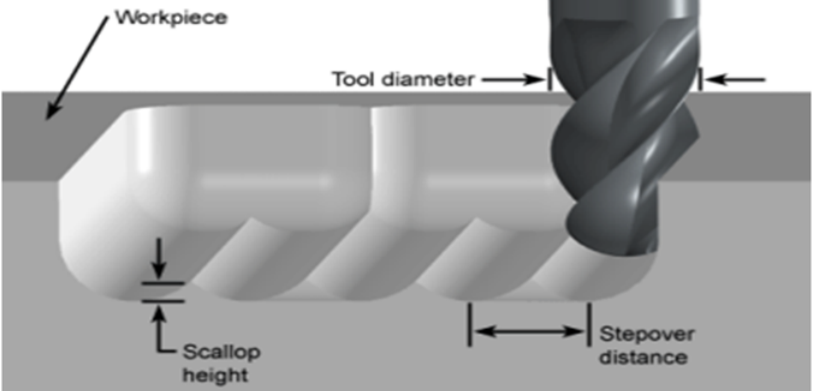
Figure 12. Scallop parameter representation.